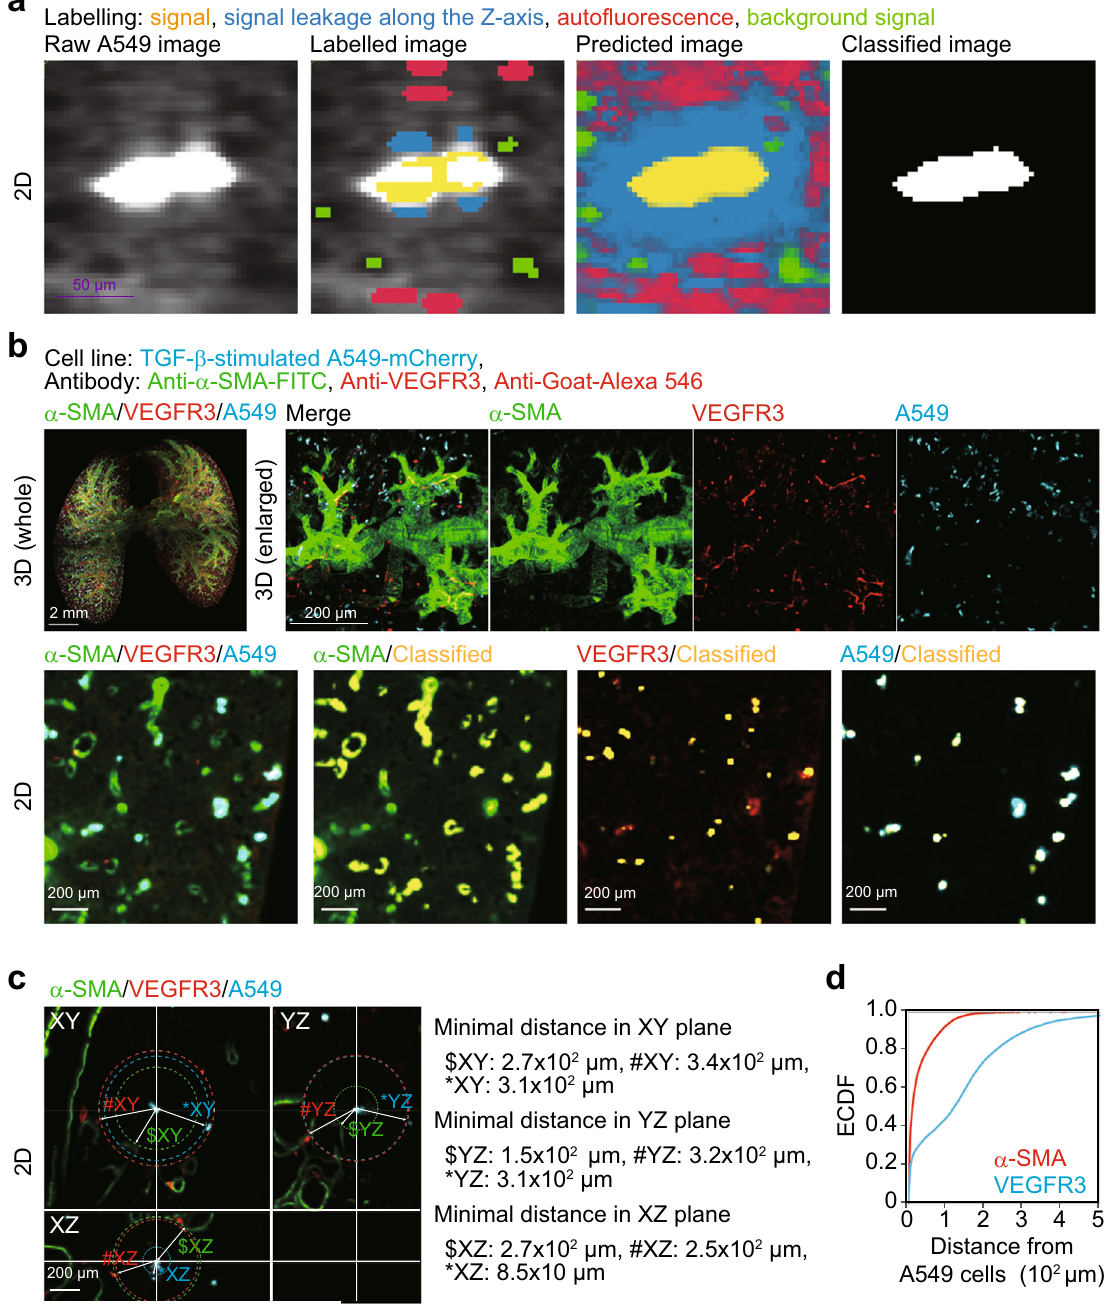
Fig. 2 Analysis of intercellular distance using whole-organ clearing protocol. Whole-lung imaging of cancer cells and the tumour microenvironment. A549-mCherry cells were intravenously injected into mice (day 0). Then, the lung was subjected to whole-organ clearing protocol (day 7) and immunostained with anti-VEGFR3 antibody, followed by co-immunostaining with Alexa 546-conjugated anti-goat IgG antibody and FITC-conjugated anti- α -SMA antibody. After pixel classi fi cation by ilastik, the original 16-bit images were converted into binary images. a The visualization of pixel classi fi cation processes. We set four annotations: yellow annotations are true signal, blue annotations are signal leakage along the Z -axis, red annotations are tissue auto fl uorescence, and green annotations are background signal. Scale bar = 50 μ m (purple). b Representative images. Yellow signals show classi fi ed signals of α -SMA, VEGFR3, and mCherry. c Quanti fi cation of minimal distance from cancer cells to α -SMA, VEGFR3, or mCherry-positive cells. $, #, and * indicate α -SMA, VEGFR3, and mCherry signal at the minimal distance from A549 in 2D plane, respectively. d The empirical cumulative distribution function (ECDF) of the minimal distance from cancer cells to α -SMA or VEGFR3 signals. 3D image (whole), scale bar = 2000 μ m. 3D image (enlarged), scale bar = 200 μ m. 2D image, scale bar = 200 μ m. Mouse number in each group is n = 3. Representative result of two independent